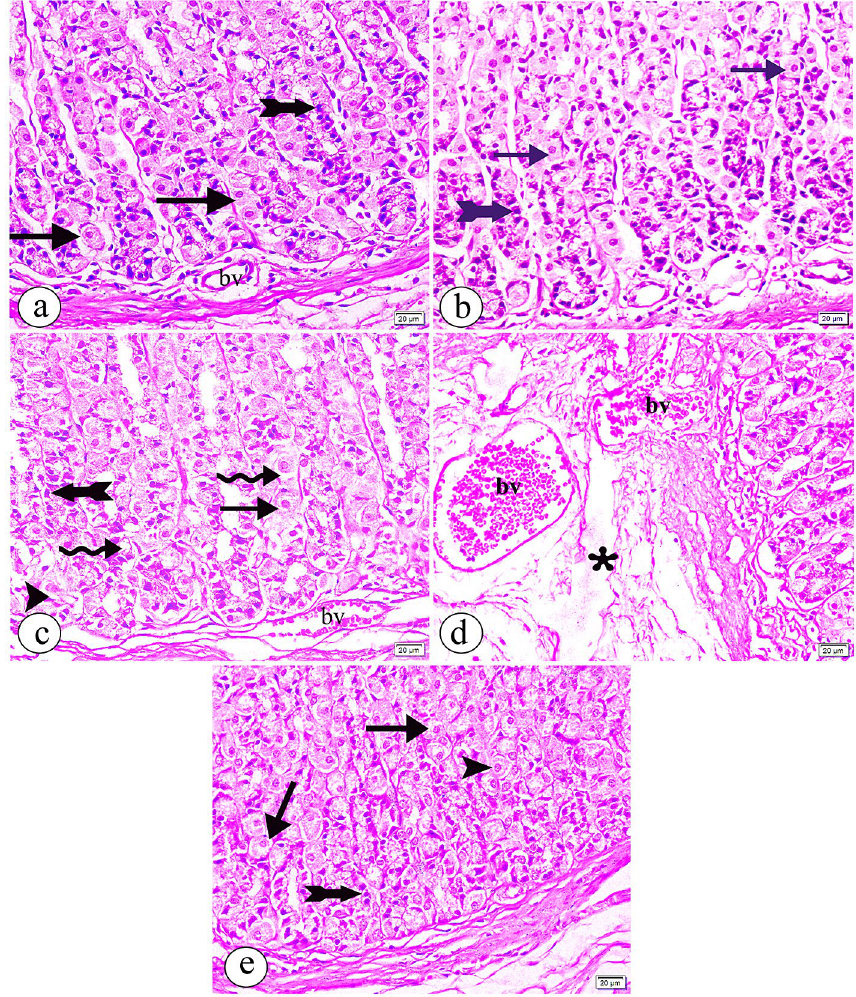
Figure 1. The photomicrographs of the sections in the glandular portion of the stomach in ( a ) the group Ӏ showing the gastric mucosa composed of the parietal cells (arrow) having a central spherical nucleus and an acidophilic cytoplasm. Small Chief cells (tailed arrow) have basal nuclei and an apical blue-purple stained cytoplasm. ( b ) the group ӀӀ showing the gastric mucosa composed of the parietal cells (arrow) and Chief cells (tailed arrow) that appear more or less than in the group Ӏ . ( c ) the group ӀӀӀ showing destructed gastric glands (arrow head) with vacuolations (curved arrow) and dilated congested blood vessels (bv). The parietal cells have dense nuclei and cytoplasm(arrow). Chief cells have a vacuolated cytoplasm (tailed arrow). ( d ) the group ӀӀӀ showing dilated congested blood vessels (bv). Submucosal oedema is observed (asterisk). ( e ) the group Ӏ V showing some parietal cells have a vacuolated cytoplasm (arrow). Other parietal cells (arrowhead) and Chief cells (tailed arrow) appear more or less than normal. Hx & E, × 400, scale bar = 20